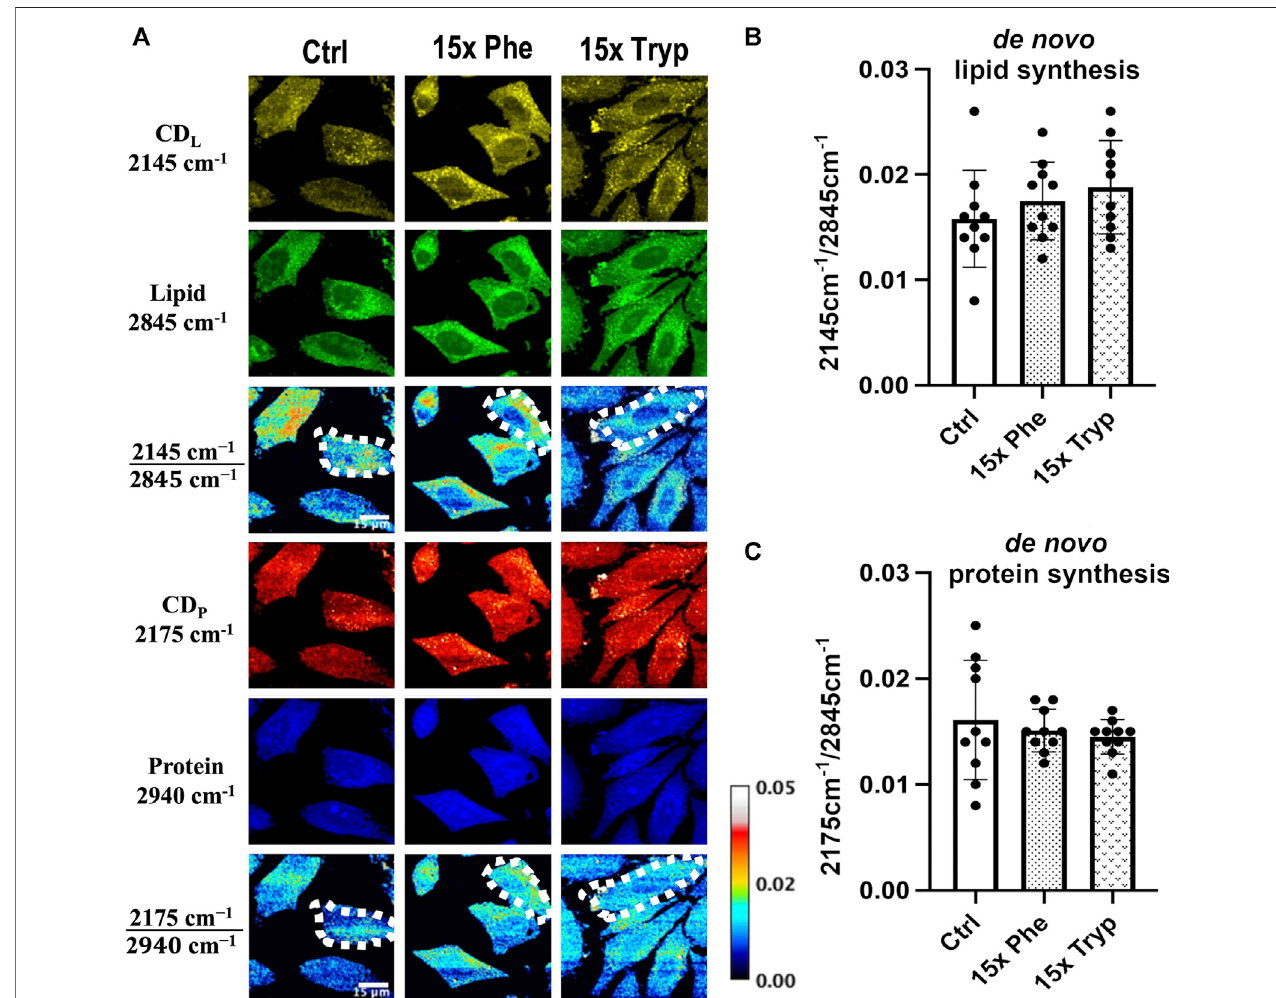
FIGURE 3 | DO-SRS microscopy visualizes in vitro protein and lipid metabolism simultaneously in HeLa cells. (A) DO-SRS microscopy visualizes Deuterium- labelled lipid (CD L ; 2145 cm − 1 ), lipid (CH 2 ; 2845 cm − 1 ), Deuterium-labelled protein (CD P ; 2175 cm − 1 ) and protein (CH 3 ; 2940 cm − 1 ) channels in in HeLa cells for control (ctrl), 15x phenylalanine (15x phe), and 15x tryptophan (15x tryp). 2145 cm − 1 the ctrl, 15x phe and 15x tryptophan 15x tryp groups. Multiple cell units are selected for calculating absolute intensities of 2145 cm − 1 experimental groups. (B,C) Ratiometric analysis of lipid and protein turnover rates to compare control group with experimental conditions with p-value of 0.1498 and 0.6816, respectively from the 2-way ANOVA